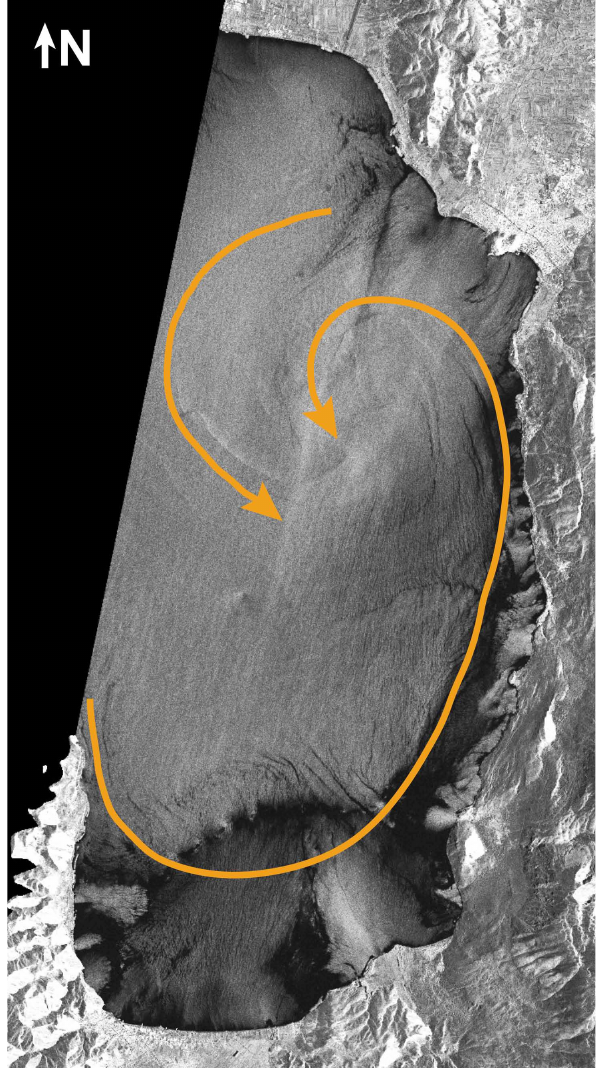
Fig. 4. Radar satellite image taken on the early morning of 30th September 2009 (© DLR 2009). Patterns seen on the wa- ter surface of Lake Ohrid probably result from differences in sur- face morphology (waves, currents) and/or density (suspension load, temperature). The image exhibits a counterclockwise rotating sur- face current with its centre in the northeastern part of Lake Ohrid. Fan-like patterns along the shoreline can probably be traced back to surface and subsurface inlets and associated differences in suspen- sion load and water temperature. During the time the radar satel- lite image was taken winds were blowing from the North with a speed of 4.6ms − 1 (National Severe Storms Laboratory Historical Weather Data Archives, Norman, Oklahoma, from their web site at